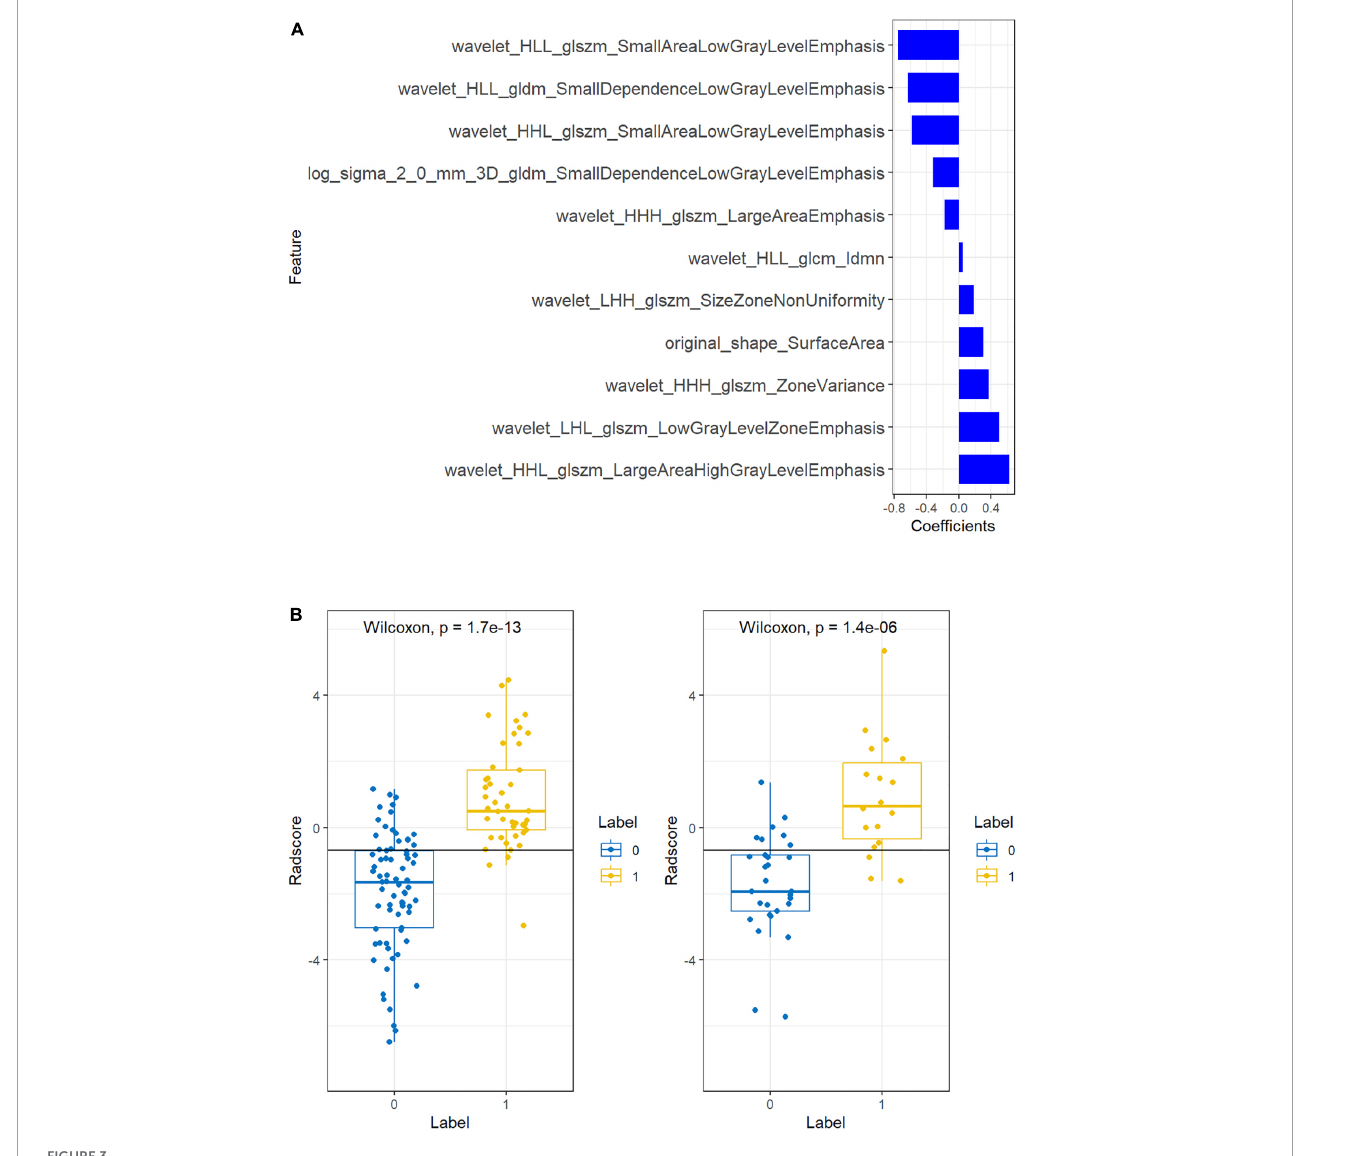
FIGURE3 Feature coefficients (A) and radiomics scores (B) .